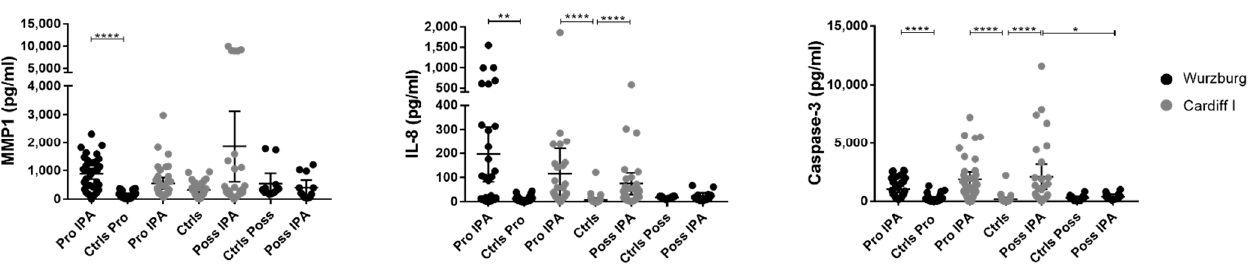
Figure 5. Investigation of MMP1, IL-8, and caspase-3 serum levels in additional alloSCT patients suffering from possible IPA (Poss IPA) and control patients (Ctrls), obtained from the University Hospital of Würzburg, Germany (black; N = 6; n = 24) and Public Health Wales Microbiology Cardiff, United Kingdom (grey; N = 11; n = 66). For direct comparison of possible IPA cases, probable IPA cases (Pro IPA) and matched controls (Ctrls) are added to the figure. Data are shown as mean values with 95% confidence intervals. Significant differences of investigated molecular candidates were investigated by the Mann–Whitney test (* p < 0.05, ** p < 0.01, **** p < 0.0001). N, number of patients; n , number of patient samples.